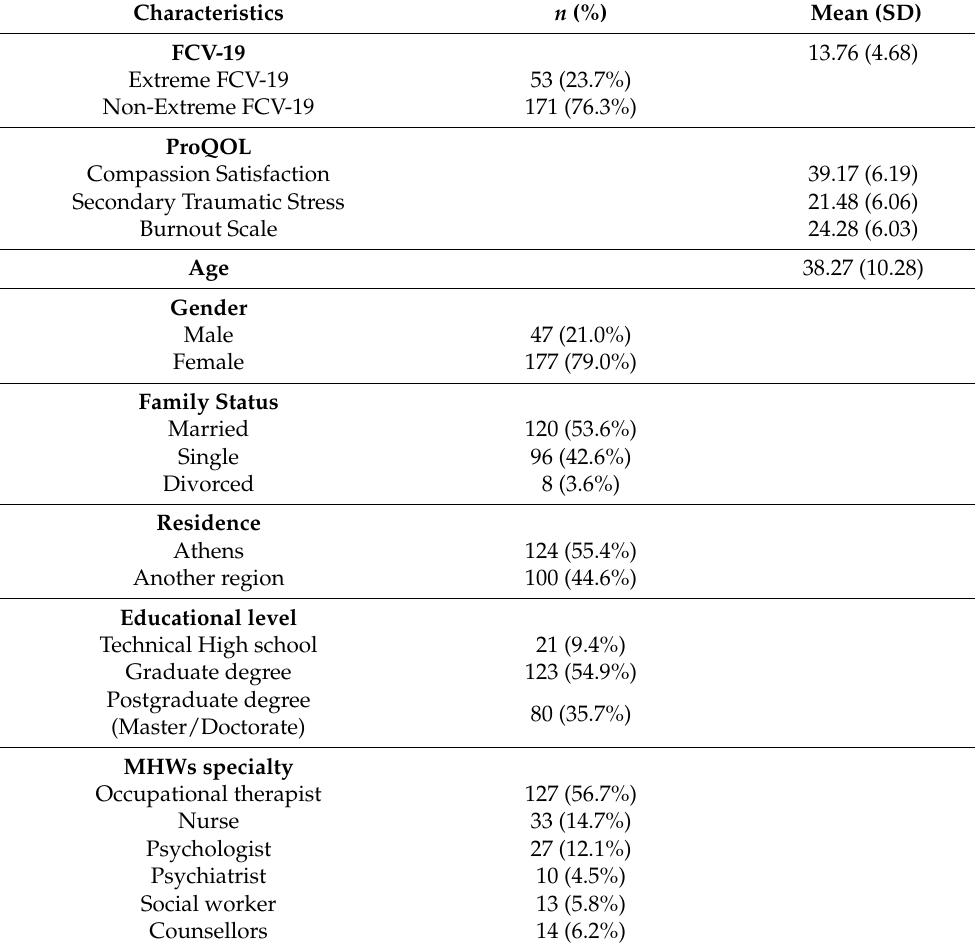
Table 1. Demographic, professional, and psychological characteristics of the